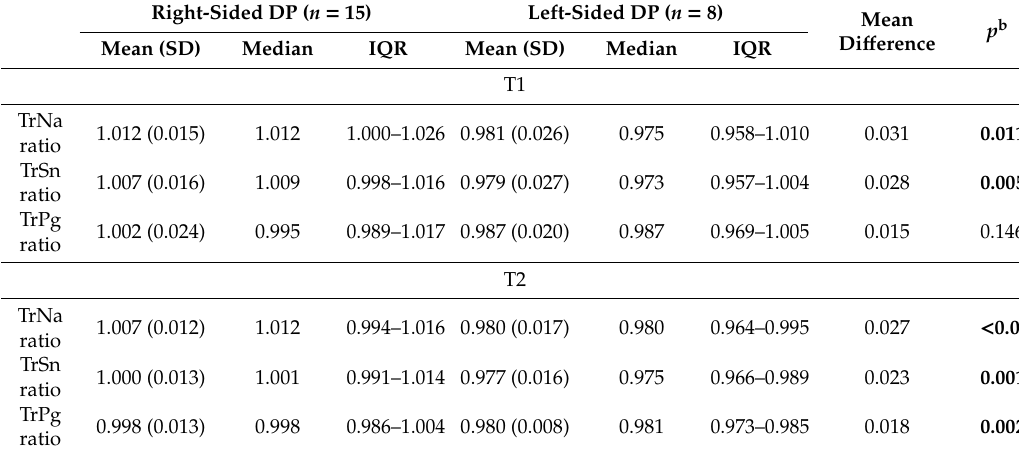
Table 4. Linear symmetry parameters (TrNa ratio, TrSN ratio, and TrPg ratio) at T1 and T2 and the di ff erence between the following subgroups: Right side as an a ff ected side of DP and left side as an a ff ected side of DP. SD = Standard deviation; IQR = Inter quartile range; Bold values denote statistical significance at the p < 0.05 level (b = Mann-Whitney nonparametric test was used).